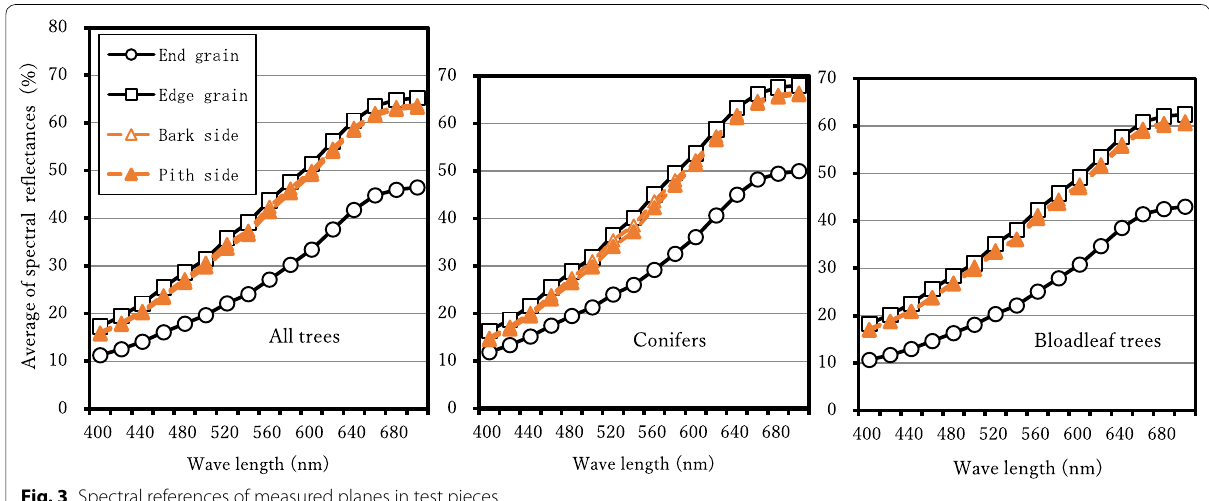
Fig. 3 Spectral references of measured planes in test